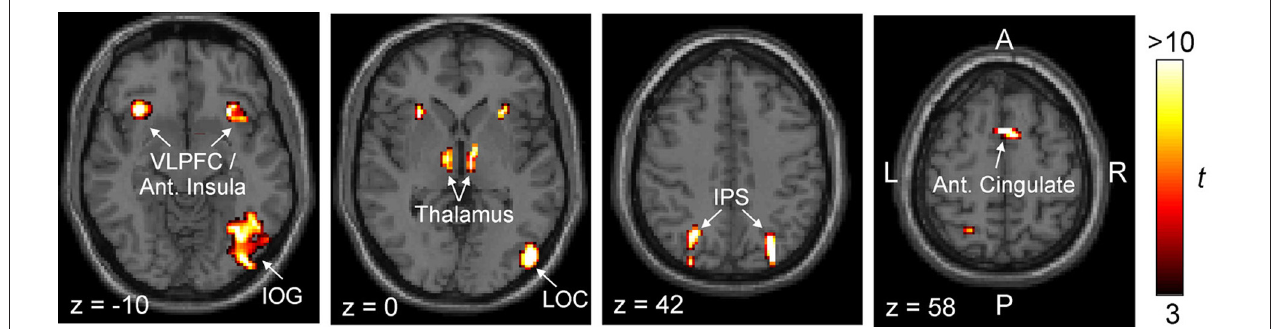
FIGURE 5 | Brain regions that are more responsive to objects in cluttered scenes than to their scrambled counterparts. Two separate statistical maps were generated, one using the strong clutter condition > scrambled control condition, and the other using the weak clutter condition > scrambled control condition, each at p < 0 . 05 (corrected). This figure shows the regions